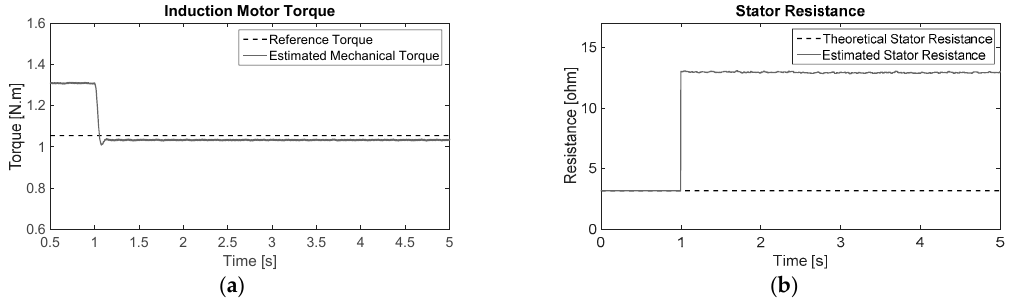
Figure 13. Conventional method to estimate the modified stator resistance (“Method 1”)—experimental results for ( a ) IM torque estimation and ( b ) IM modified stator resistance estimation.